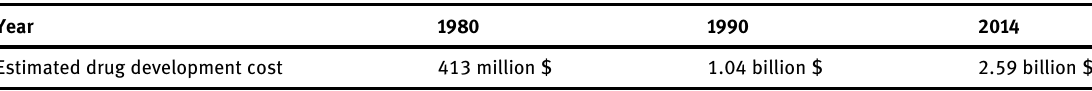
Table  : The estimated cost for drug development over the past four